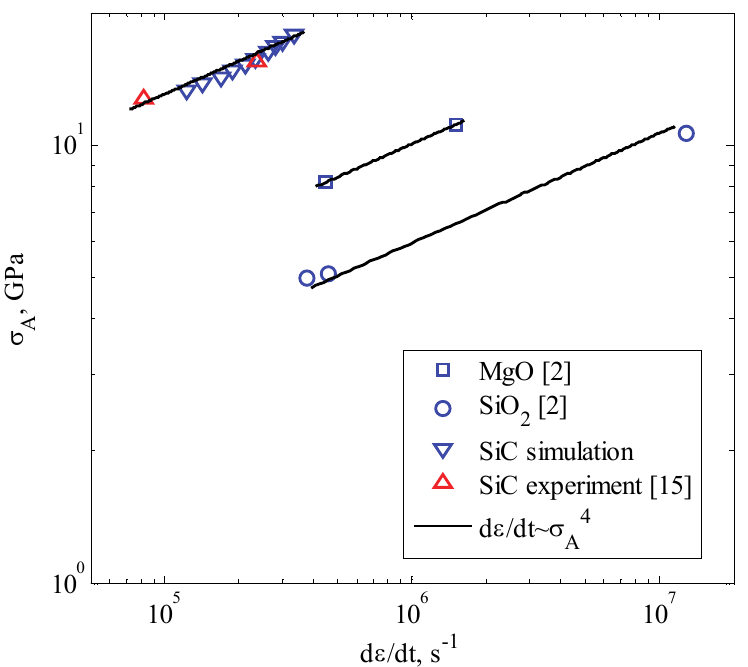
Figure 9: Dependences of the amplitude of stresses versus the strain rate at the front of the shock wave for